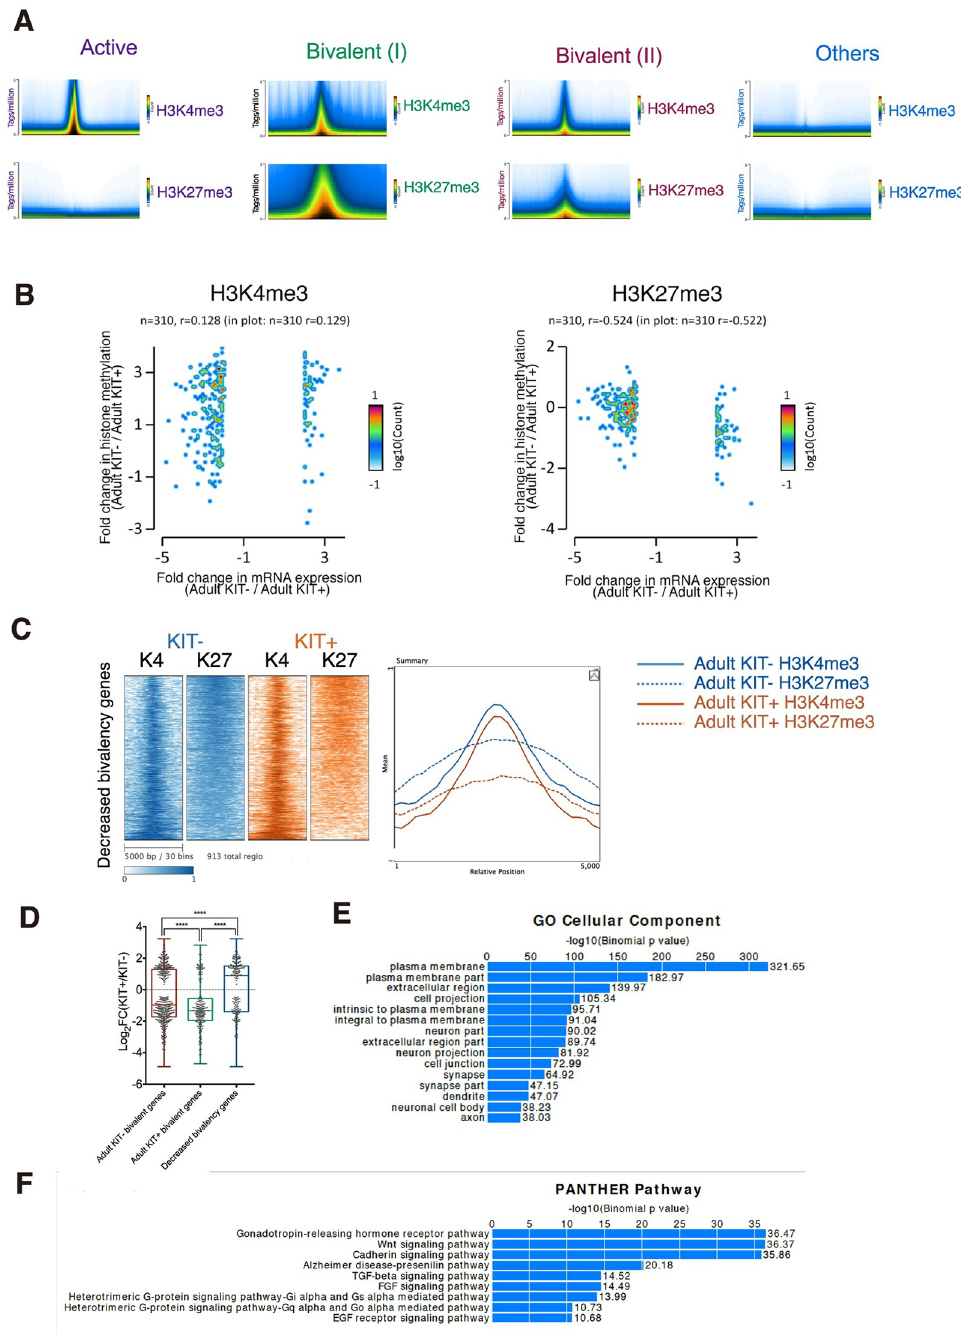
Fig 5. Gene bivalency on transcriptional regulation during the adult KIT transition. (A) The average profile plots for each category of promoter. (B) Negative correlation of H3K27me3 difference and gene expression fold change. (C) Heat maps (Left) and meta-plot (Right) of histone modifications across the 5 kb region centered at the TSSs of the genes with decreased bivalency during the KIT transition. (D) Box plots represent the spread of the gene expression changes as a result of the loss of bivalency during the adult KIT transition. The whiskers represent 5–95 percentile with the medians shown as horizontal lines. The p-values were calculated using unpaired, two-tailed t-test with 95% confidence. (E) Bar plot showing enrichment of biological processes for genes with decreased bivalency. (F) Bar plot showing enrichment of biological processes for genes associated with decreased H3K27me3 marks during SSC aging.